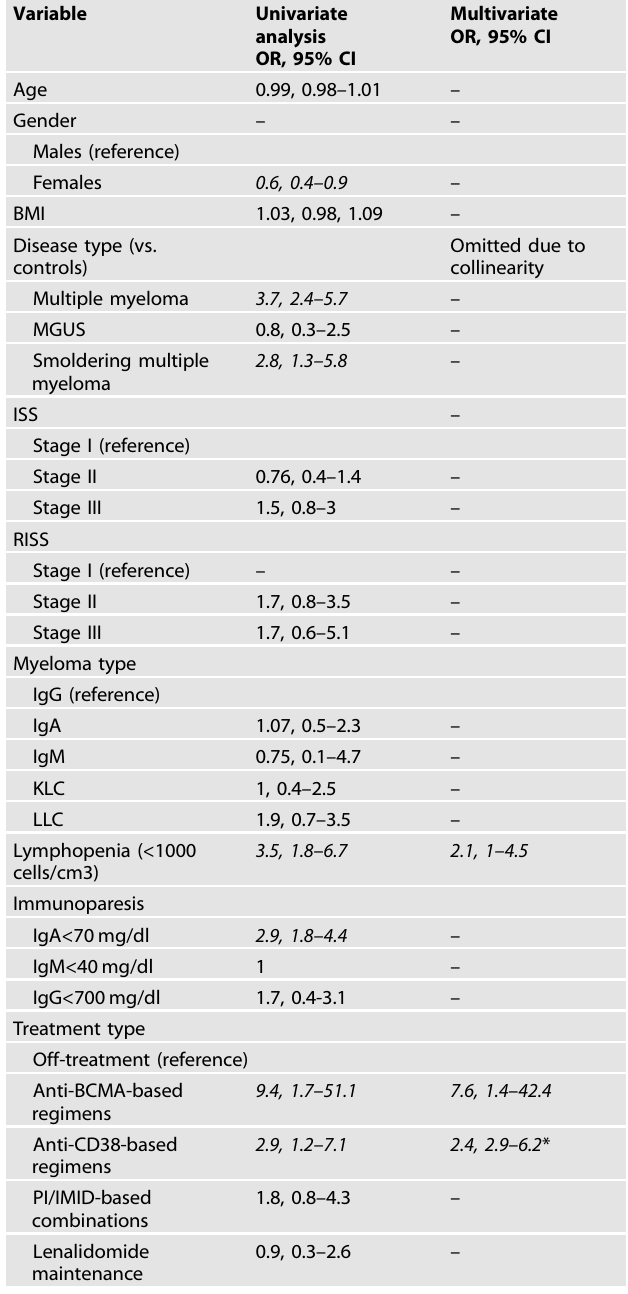
Table 3. Univariate and multivariate analysis for NAbs titers <50% among patients with symptomatic MM on day